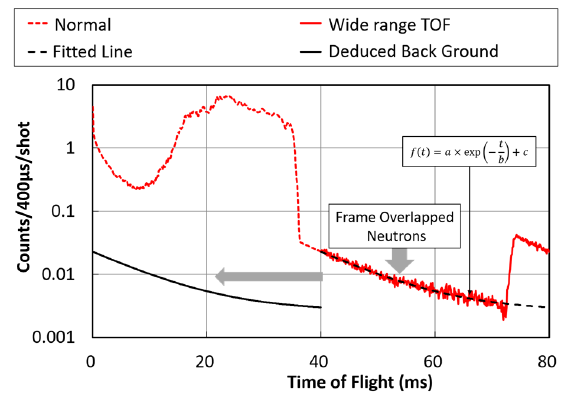
Figure 11. Broad range TOF spectrum after 40 ms and normal TOF spectrum in comparison with the fitted result and the de- duced frame overlap and constant backgrounds.